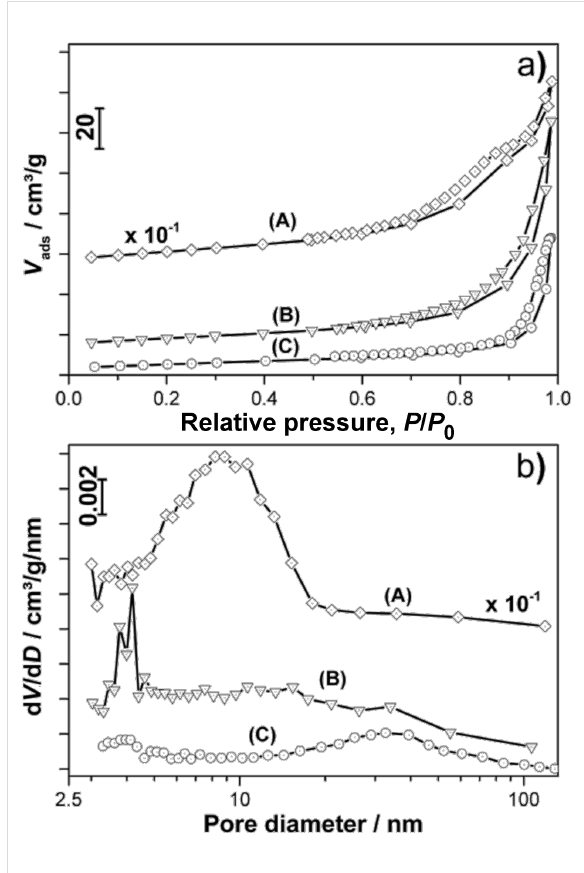
Figure 8: a) N 2 adsorption–desorption isotherms (volume adsorbed versus relative pressure, P / P 0 ) and b) the corresponding pore size distributions of the (A) Mn 3 O 4 , (B) Mn 5 O 8 and (C) α -Mn 2 O 3